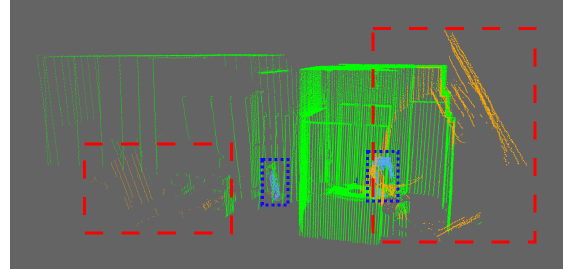
Figure 9: Cleaned scan of room with two mirrors. Valid points are green, points on the mirror planes are turquoise, and points behind the mirror planes are